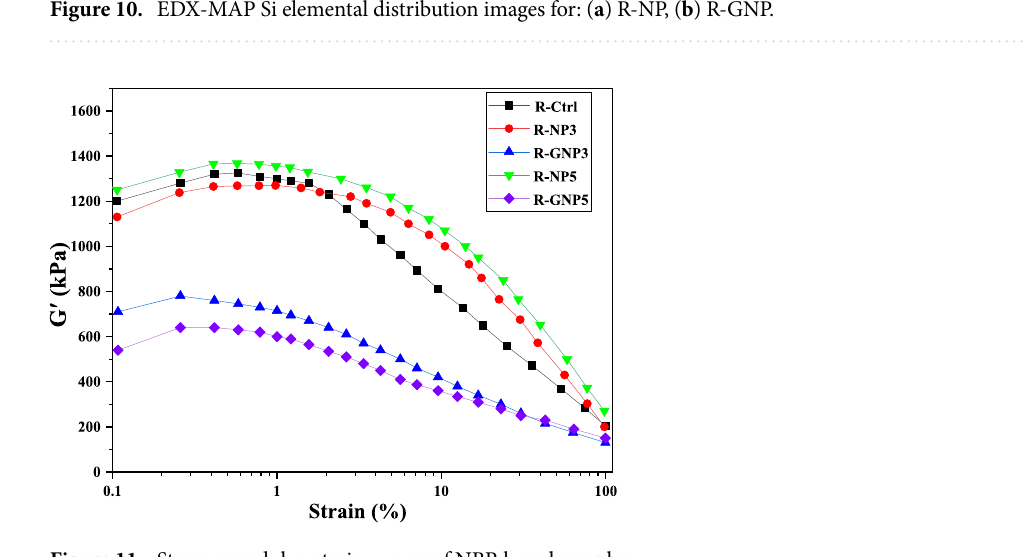
Figure 11. Storage modulus-strain curves of NBR based